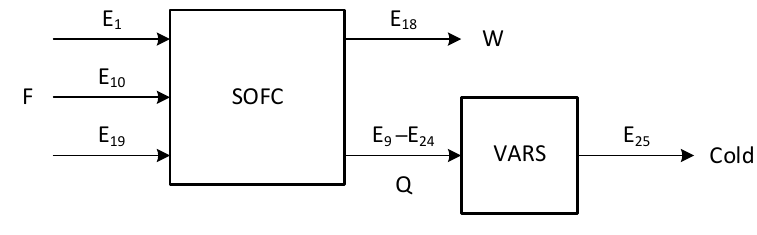
Figure 5. SOFC-VARS Integrated System.